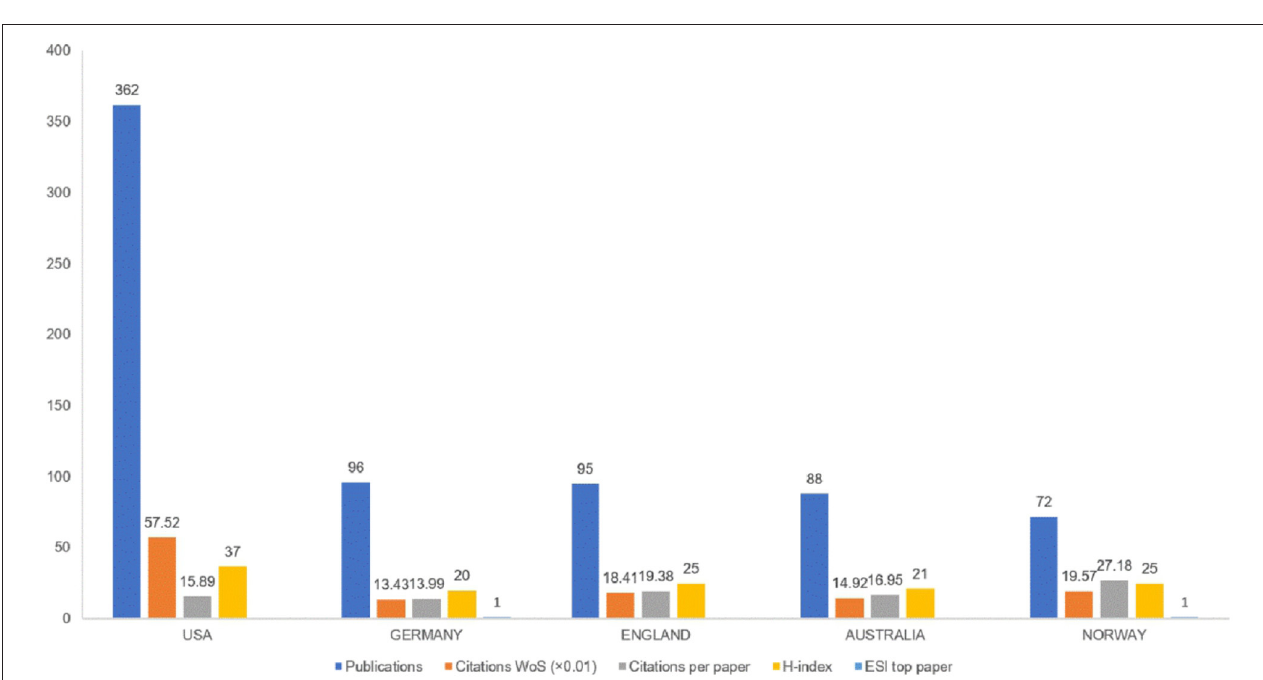
FIGURE 3 | Publications, citations on WoS ( × 0.01), citations per study, H-index, and ESL top study among top five countries or regions.